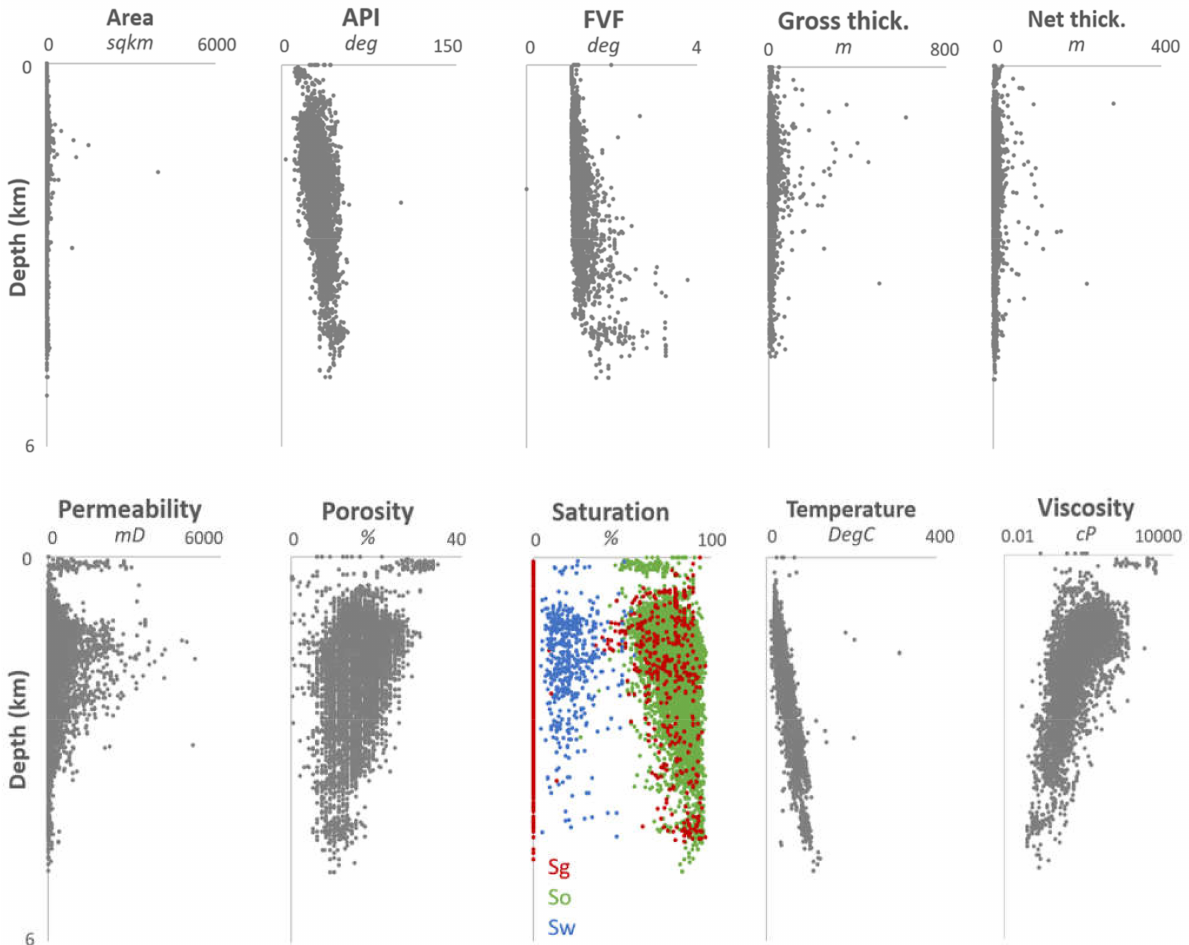
Figure 7. Cross-plots for various attributes against depth for Basin X